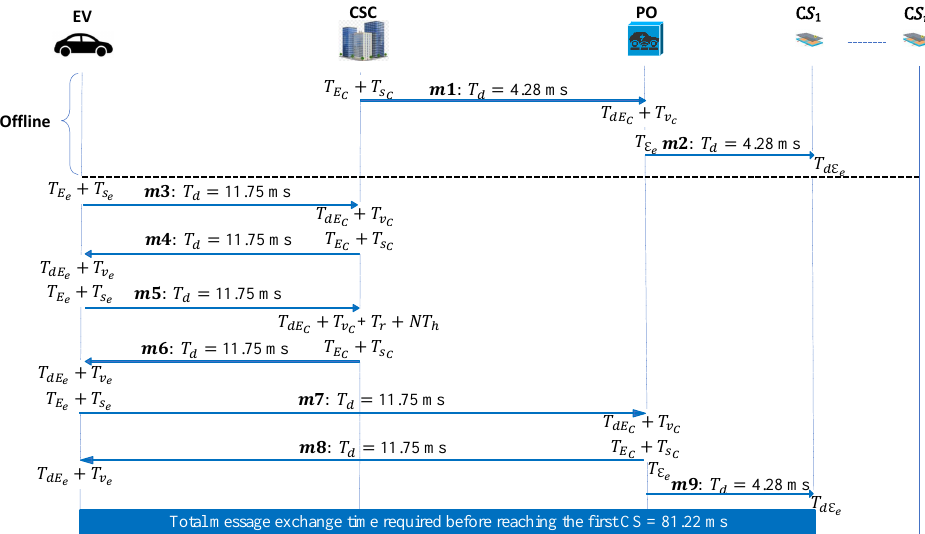
Figure 6. Time required for EV registration and authentication with the CSC and the PO before reaching the first charging